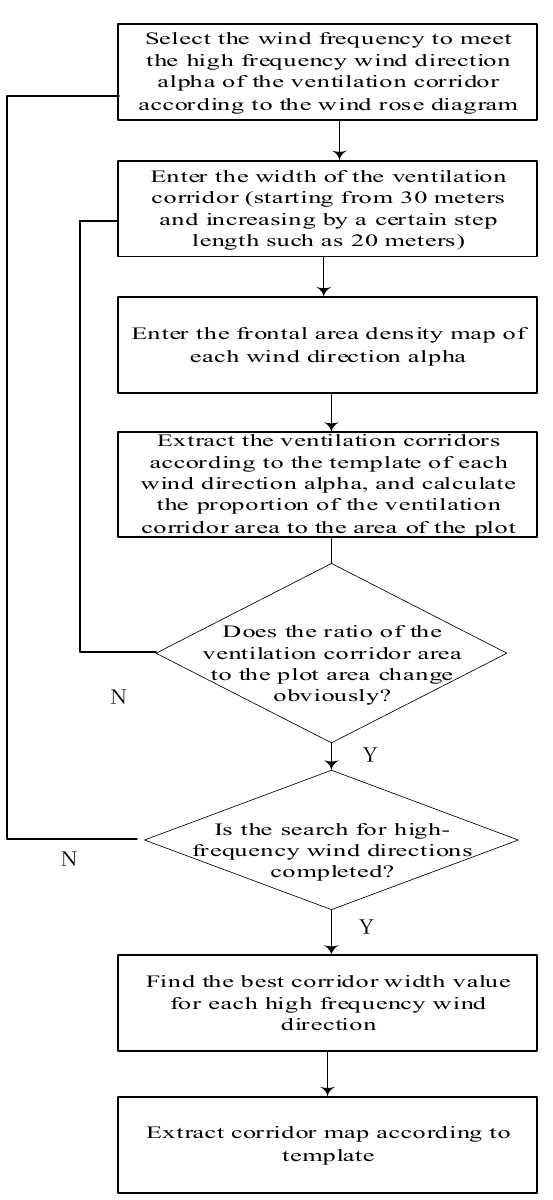
Figure 12. Flow chart of the optimal width for automatic mining of an urban ventilation corridor. Initially set the length of the corridor, extract three dominant wind directions, and set the best corridor width as width1, width2, and width3